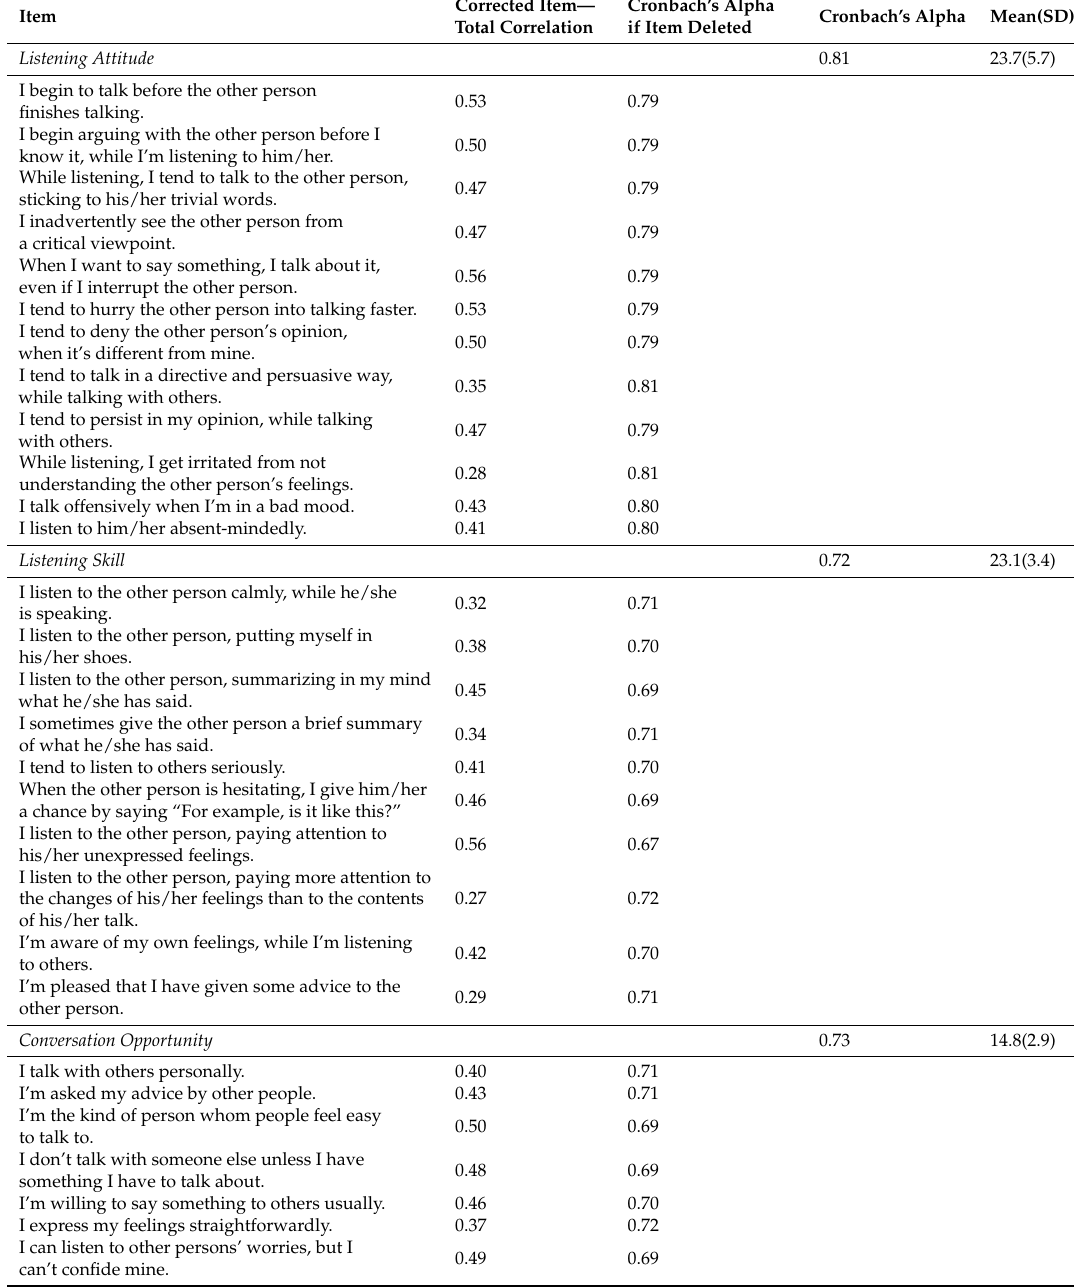
Table 3. Corrected Item-Total Correlations, internal consistency reliability and